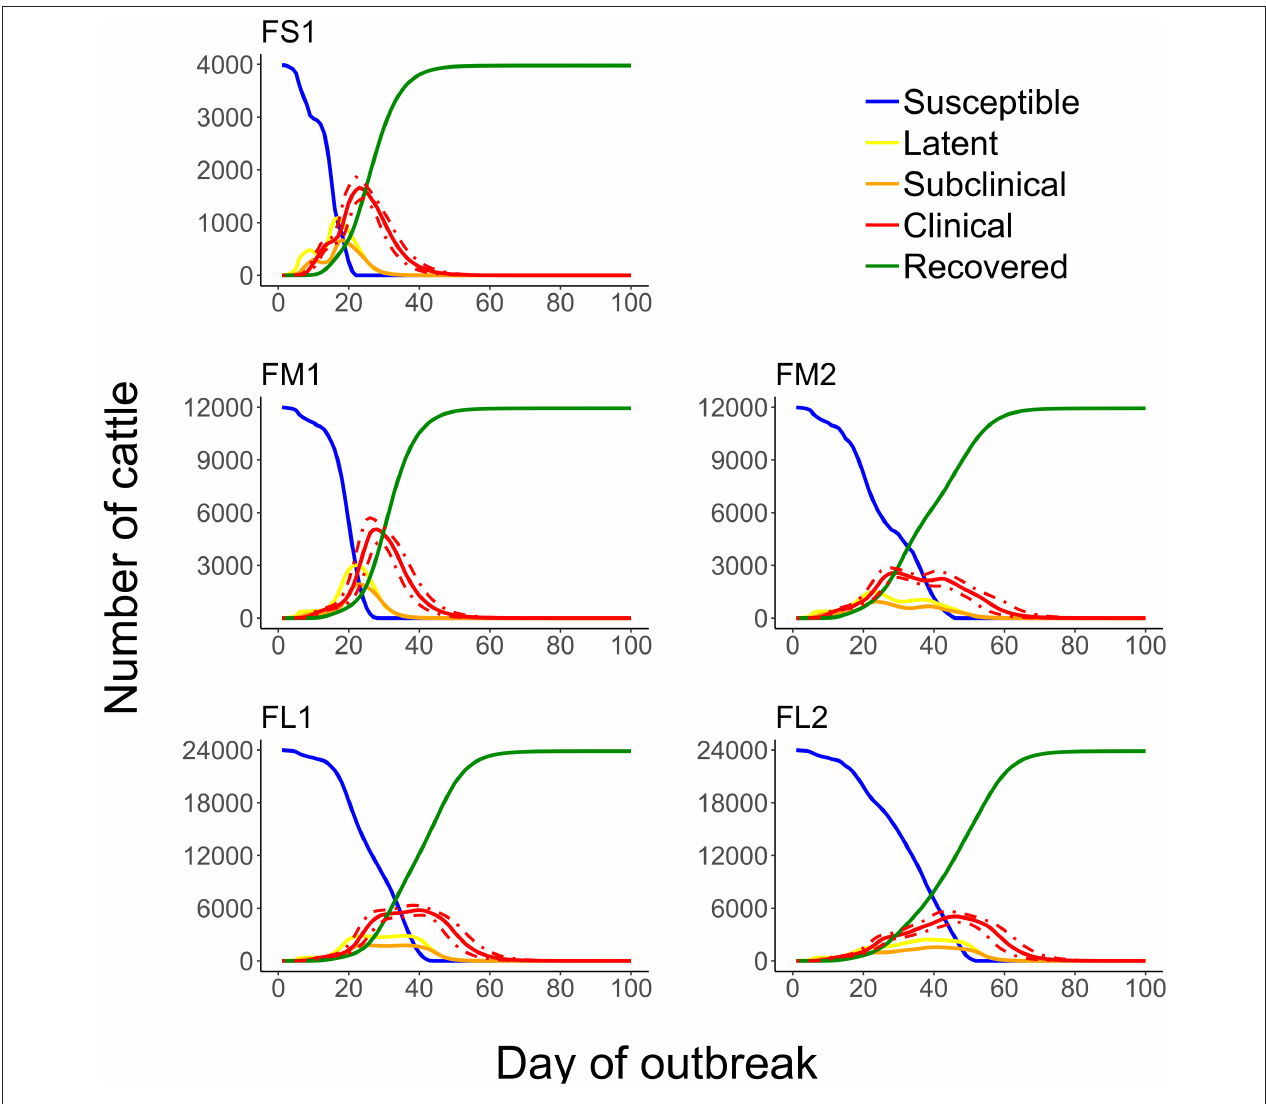
FIGURE 8 | Numbers of cattle in each of the foot-and-mouth disease infection and disease stages during projected outbreaks on U.S. beef cattle feedlots. The solid lines represent the 50th percentiles for the cattle numbers in the infection stages and the red dotted lines represent the 25th and 75th percentiles for the number of cattle with clinical FMD (infectious and non-infectious clinical cattle) of n = 2,000 simulated outbreaks in the feedlot of that size and layout sampling the values of the target parameters. Feedlot size and layout cases modeled: FS1 is a 4,000 cattle feedlot with one hospital-pen; FM1 is a 12,000 cattle feedlot with one hospital-pen; FM2 is a 12,000 cattle feedlot with two hospital-pens; FL1 is a 24,000 feedlot with two hospital-pens; and FL2 is a 24,000 cattle feedlot with four hospital-pens (in all the layouts n = 200 cattle per home-pen).